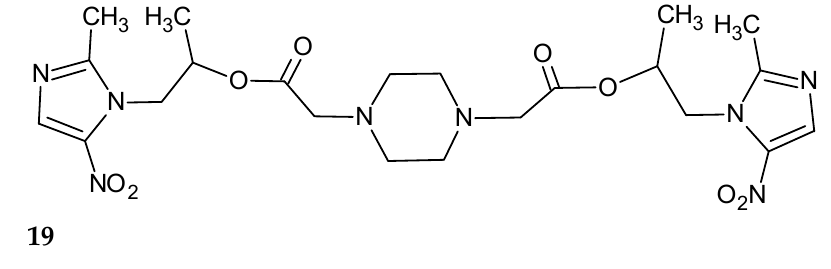
Figure 11. The structure of the compound ( 19